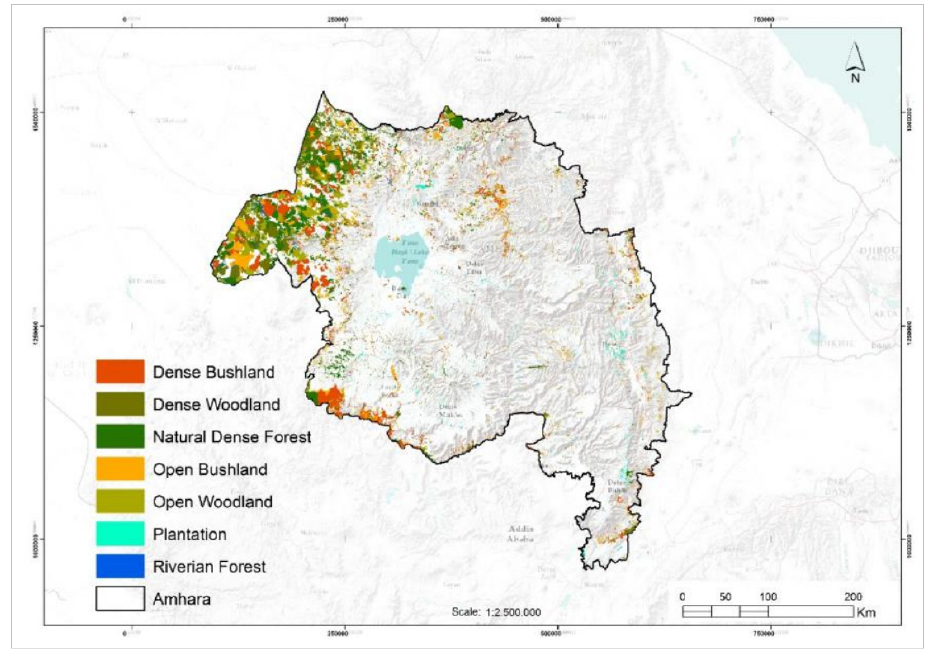
Figure 2. Vegetation of Amhara National Regional State (ANRS) (only different types of forest land are displayed in color).